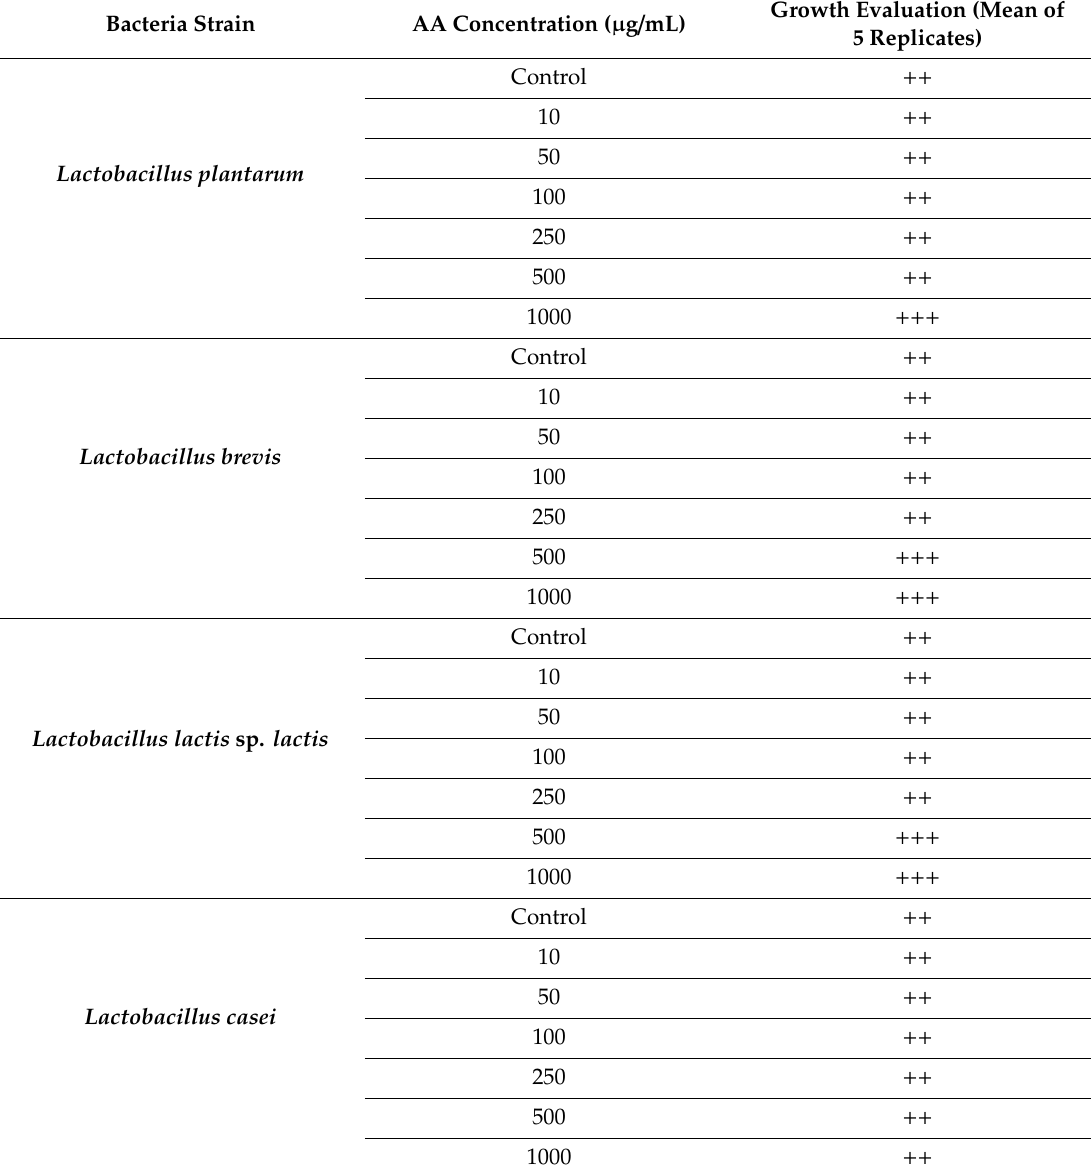
Table 1. Impact of acrylamide on the growth of Lactobacillus strains on solid